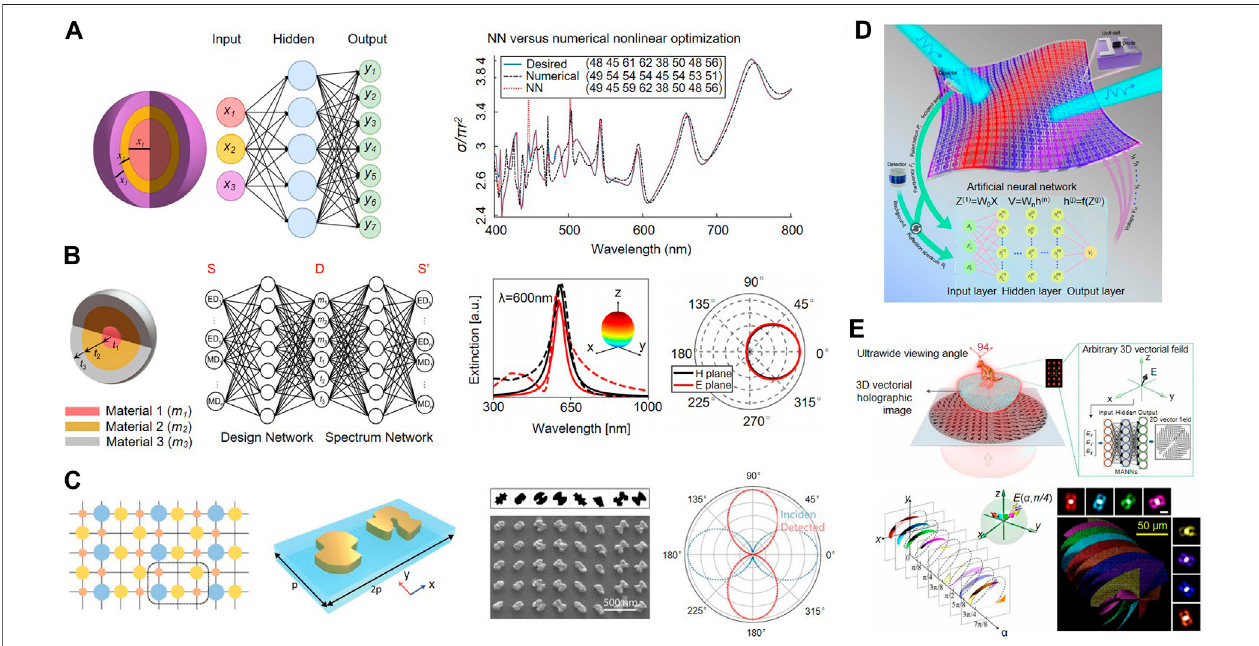
FIGURE 3 | Photonic designs enabled by deep learning models. (A) Nanophotonic particle scattering simulation. Reproduced from Peurifoy et al. (2018) with permissionfromAmericanAssociationfortheAdvancementofScience. (B) Simultaneousdesignofmaterialandstructureofnanosphereparticles.ReproducedfromSo et al. (2019) with permission from American Chemical Society. (C) Inverse design of metallic metamolecules. Reproduced from Liu et al. (2020) with permissionfrom the WILEY-VCHVerlagGmbH&Co.KGaA,Weinheim. (D) Self-adaptiveinvisibilitycloak.ReproducedfromQianetal.(2020)withpermissionfromSpringerNature. (E) Optical vectorial hologram design of a 3D-kangaroo projection. Reproduced from Ren et al. (2020) with permission from American Association for the Advancement of Science.